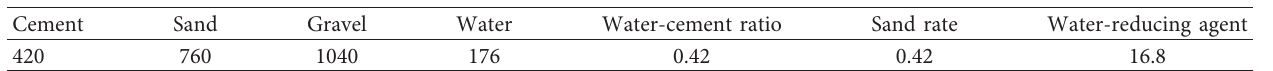
Table 3: Concrete mix ratio (kg/m 3